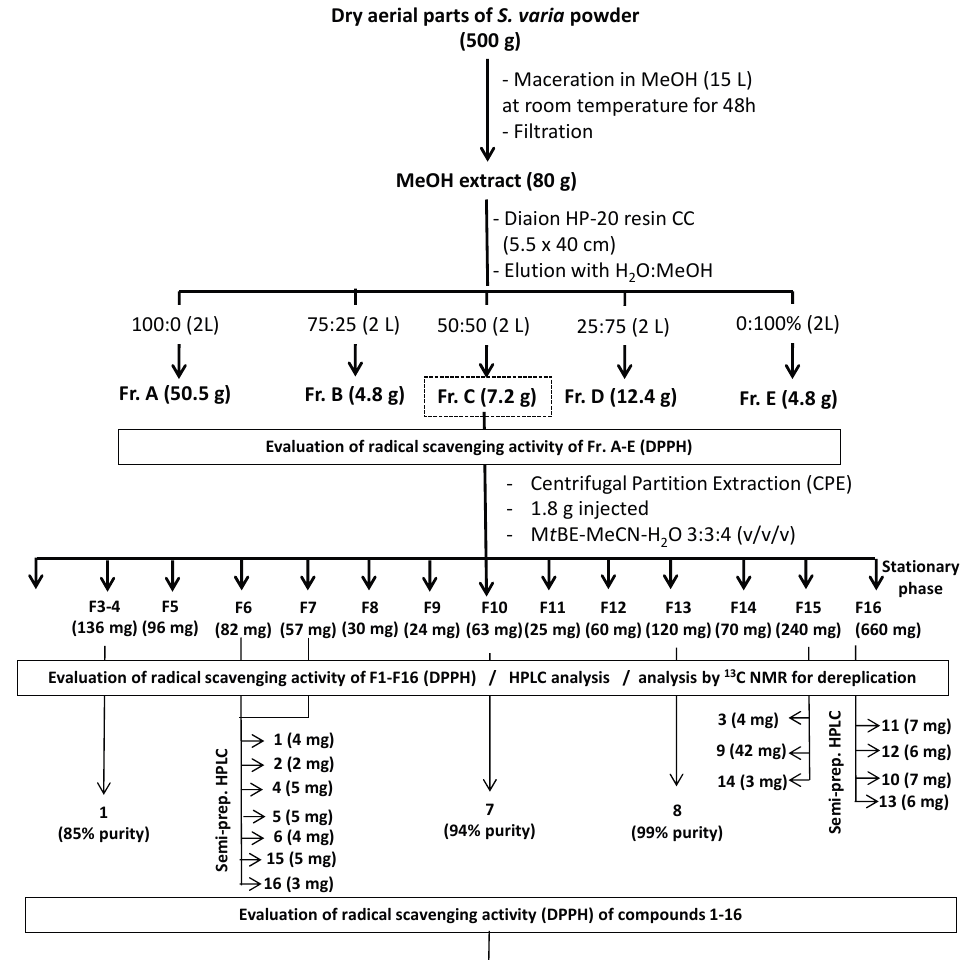
Figure 4. Extraction scheme for isolation of antioxidant compounds from S. varia aerial